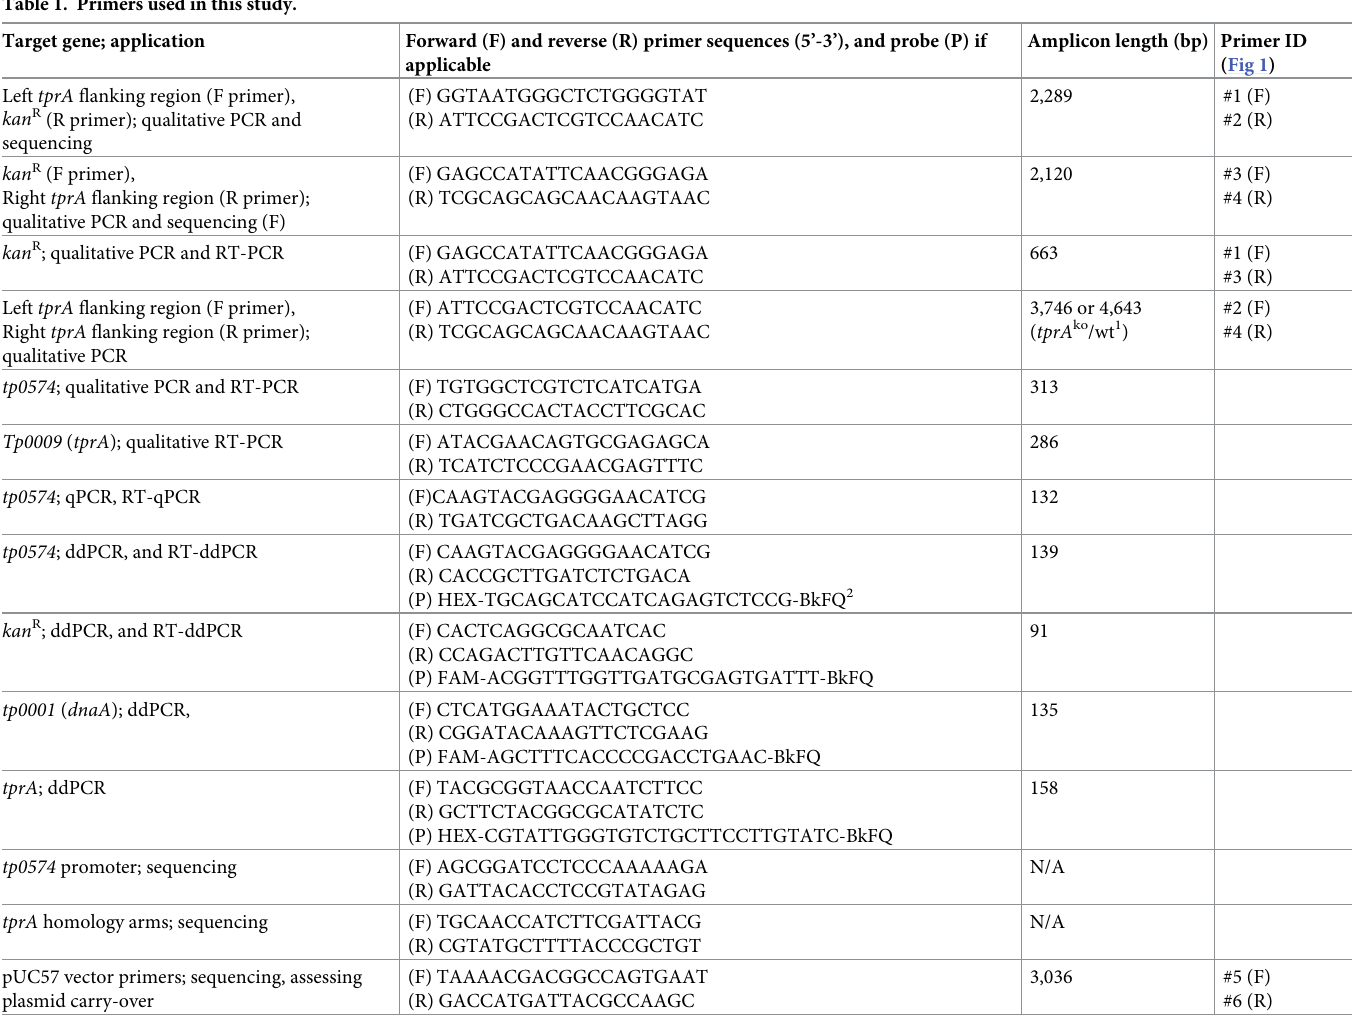
Table 1. Primers used in this